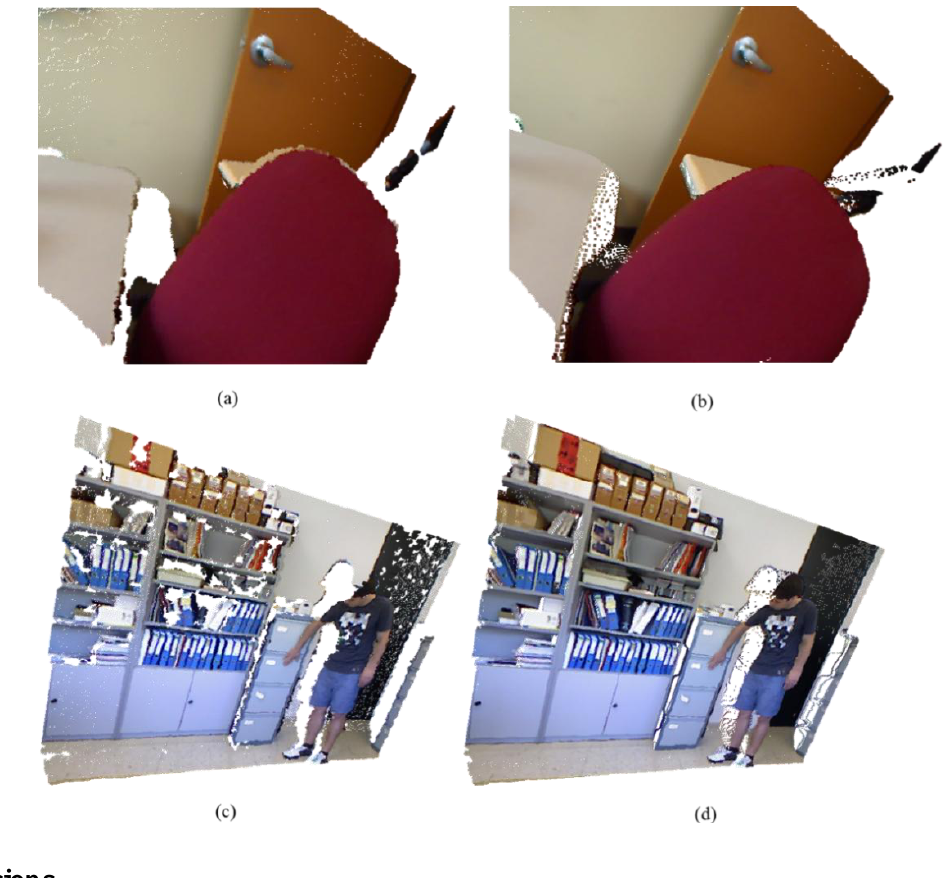
Figure 20. 3-D rendered color images using: ( a , c ) raw depth map; ( b , d ) the depth map obtained by the proposed